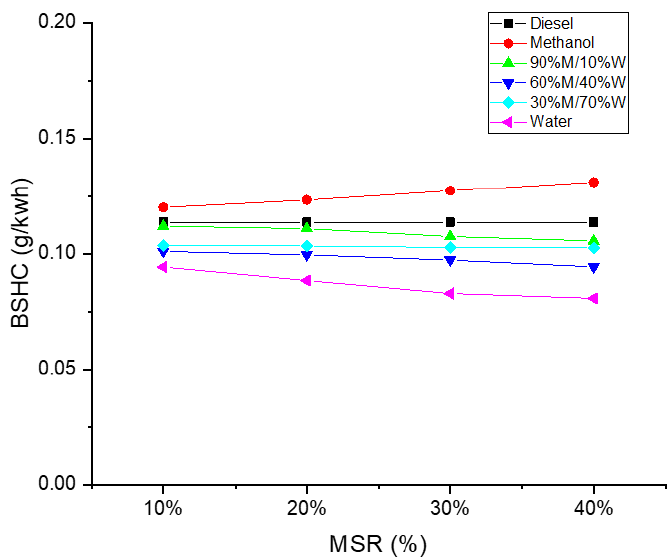
Figure 9. HC emission changes with different fuel mixture ratios.